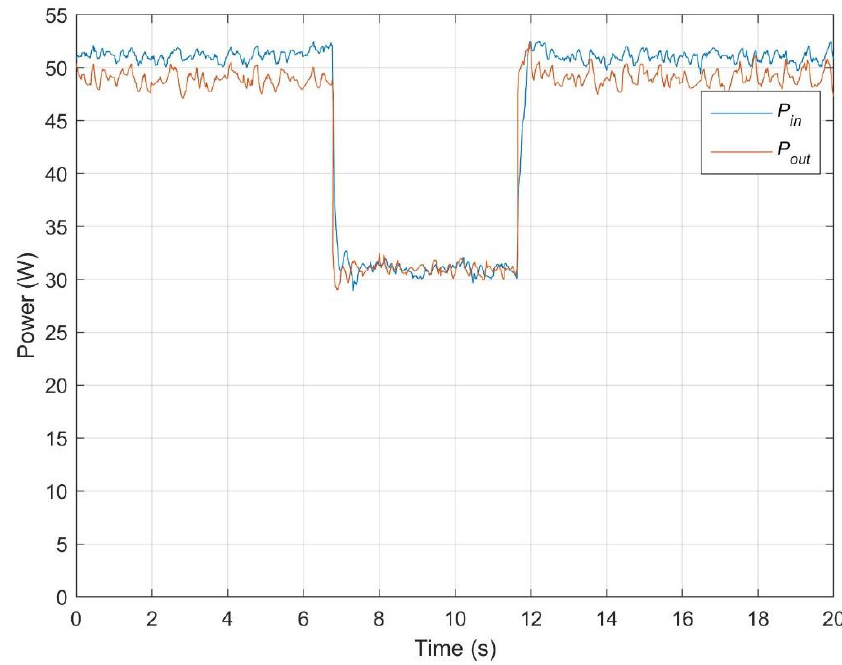
Figure 13. DC/DC converter power.